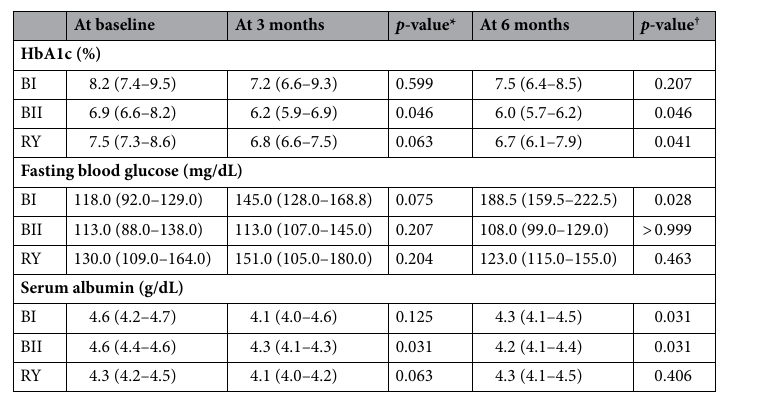
Table 2. Changes in HbA1c, fasting blood glucose and serum albumin levels after surgery. Data are presented as medians (interquartile rages). BI Billroth I, BII Billroth II, RY Roux-en-Y. *p-value comparing baseline with 3 months. † p-value comparing baseline with 6